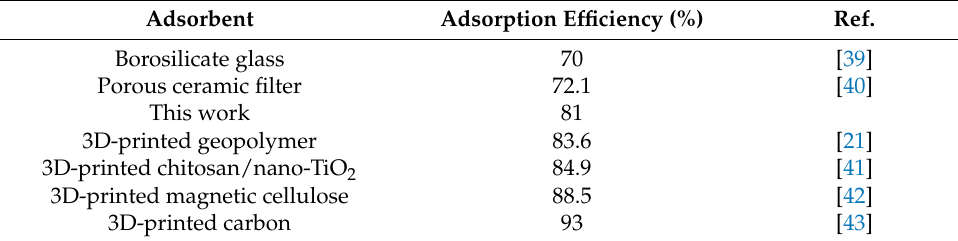
Table 2. A comparison of adsorbents with their adsorption efficiency for methylene blue dye.